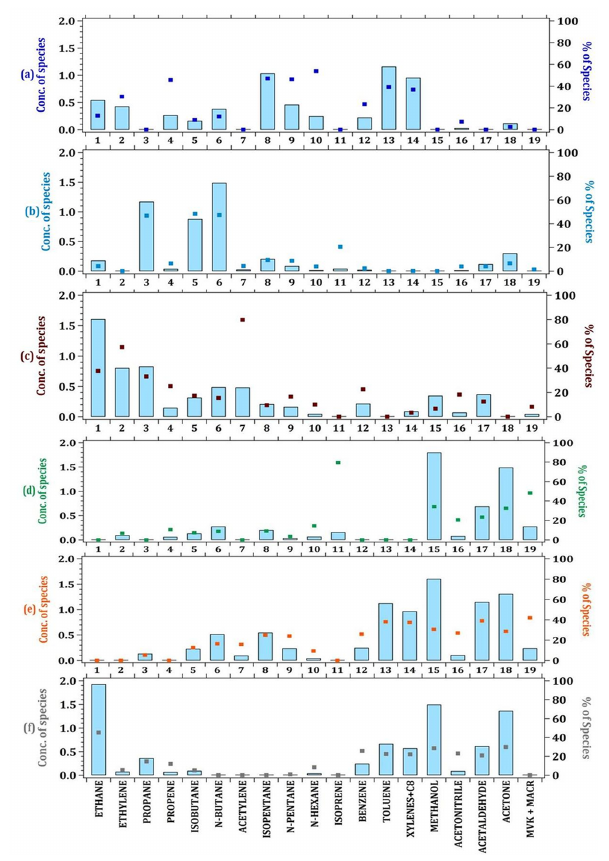
Figure 8. Source composition profiles of the six-factor PMF solu- tion. The concentrations (µgm − 3 ) and the percent of each species apportioned to the factor are displayed as a pale blue bar and a color box, respectively. (a) F1 – motor vehicle exhaust; (b) F2 – evapo- rative sources; (c) F3 – wood-burning; (d) F4 – biogenic; (e) F5 – solvent use; (f) F6 – natural gas and background.